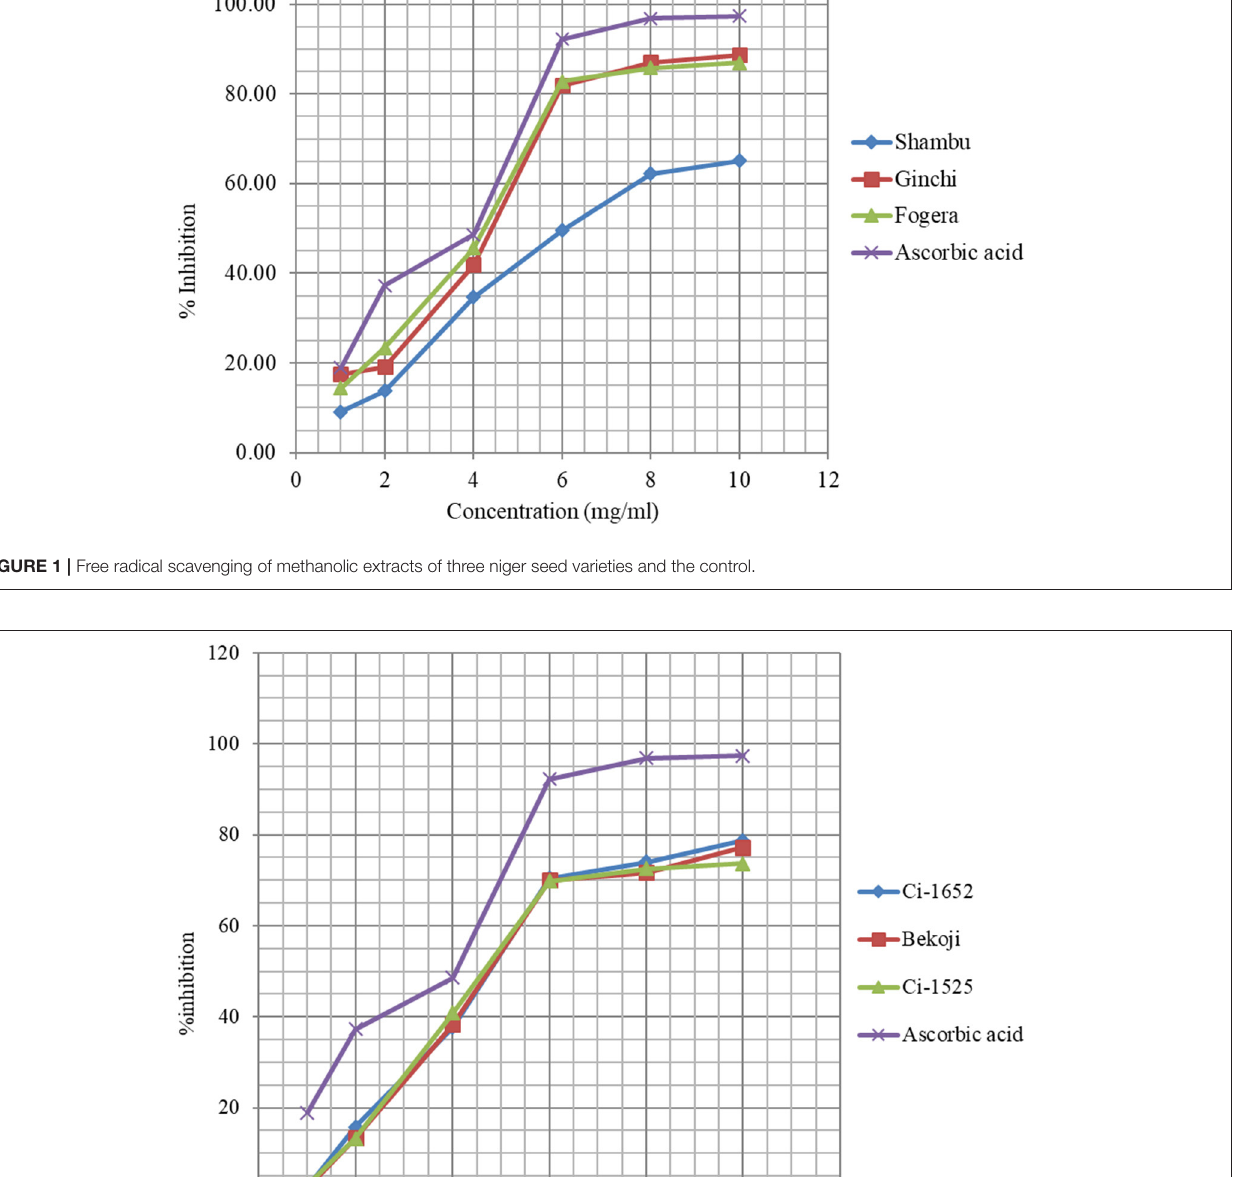
phenolics, sterols, and carotenoids. Apart from these, the presence of Milliard reaction products extracted by the polar solvents could also be contributing to the increased radical scavenging activity. The EC 50 (sample concentrations